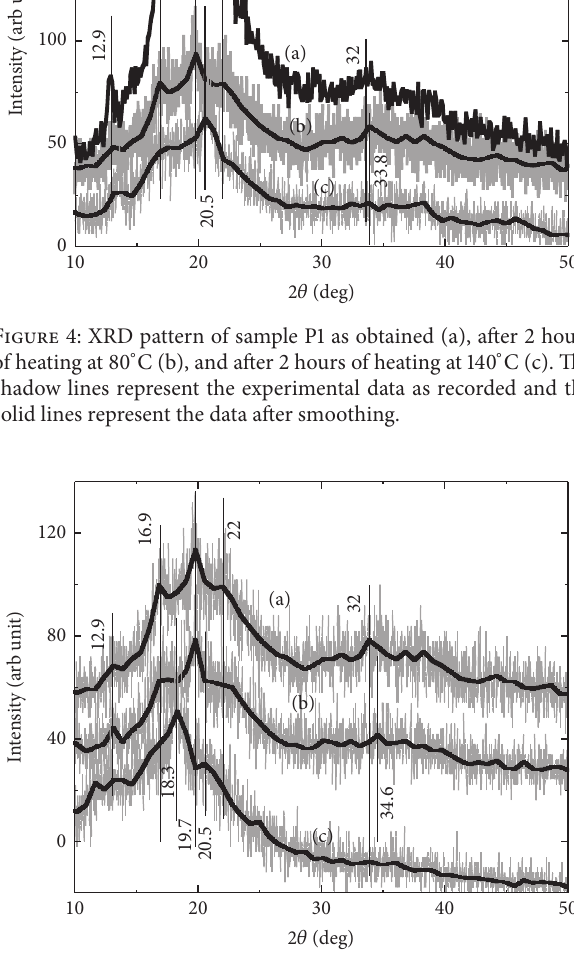
Figure 5: The XRD diffractograms of samples P1–P3 heated 2 hours at 80 ∘ C: (a) sample P1, (b) sample P2, and (c) sample P3. The shadow lines represent the experimental data as recorded and the solid lines represent the data after